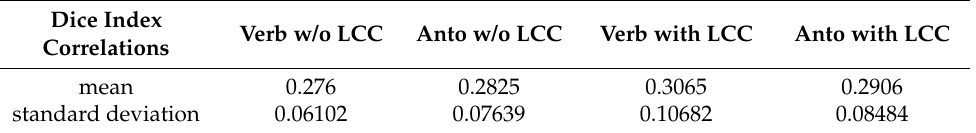
Table 3. Mean and standard deviation of the Dice index correlations of the best fitting ICs to the TB-fMRI results of verb and antonym generation with and without the linguistic control condition (verb = verb generation; anto = antonym generation; w/o LCC = without linguistic control condition; with LCC = with linguistic control